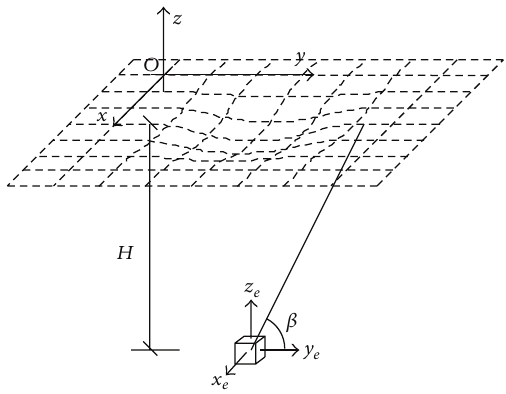
Figure 1: Calculation model for unit